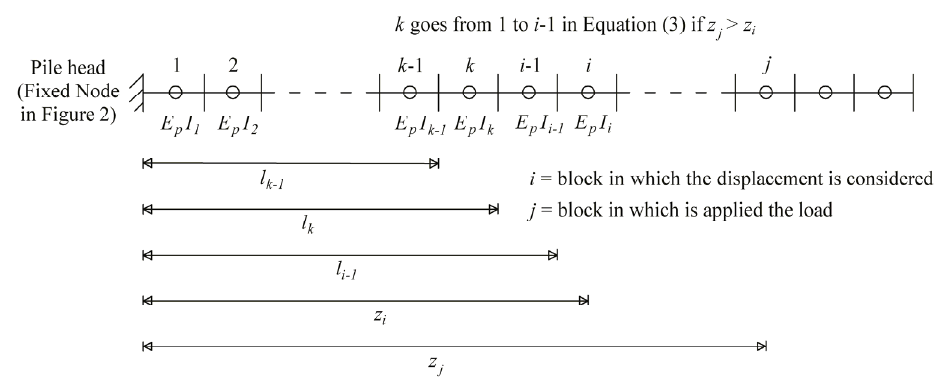
Figure 3. Scheme for the flexibility matrix of a pile modeled as a beam with variable flexural rigidity (see Equation (3)).